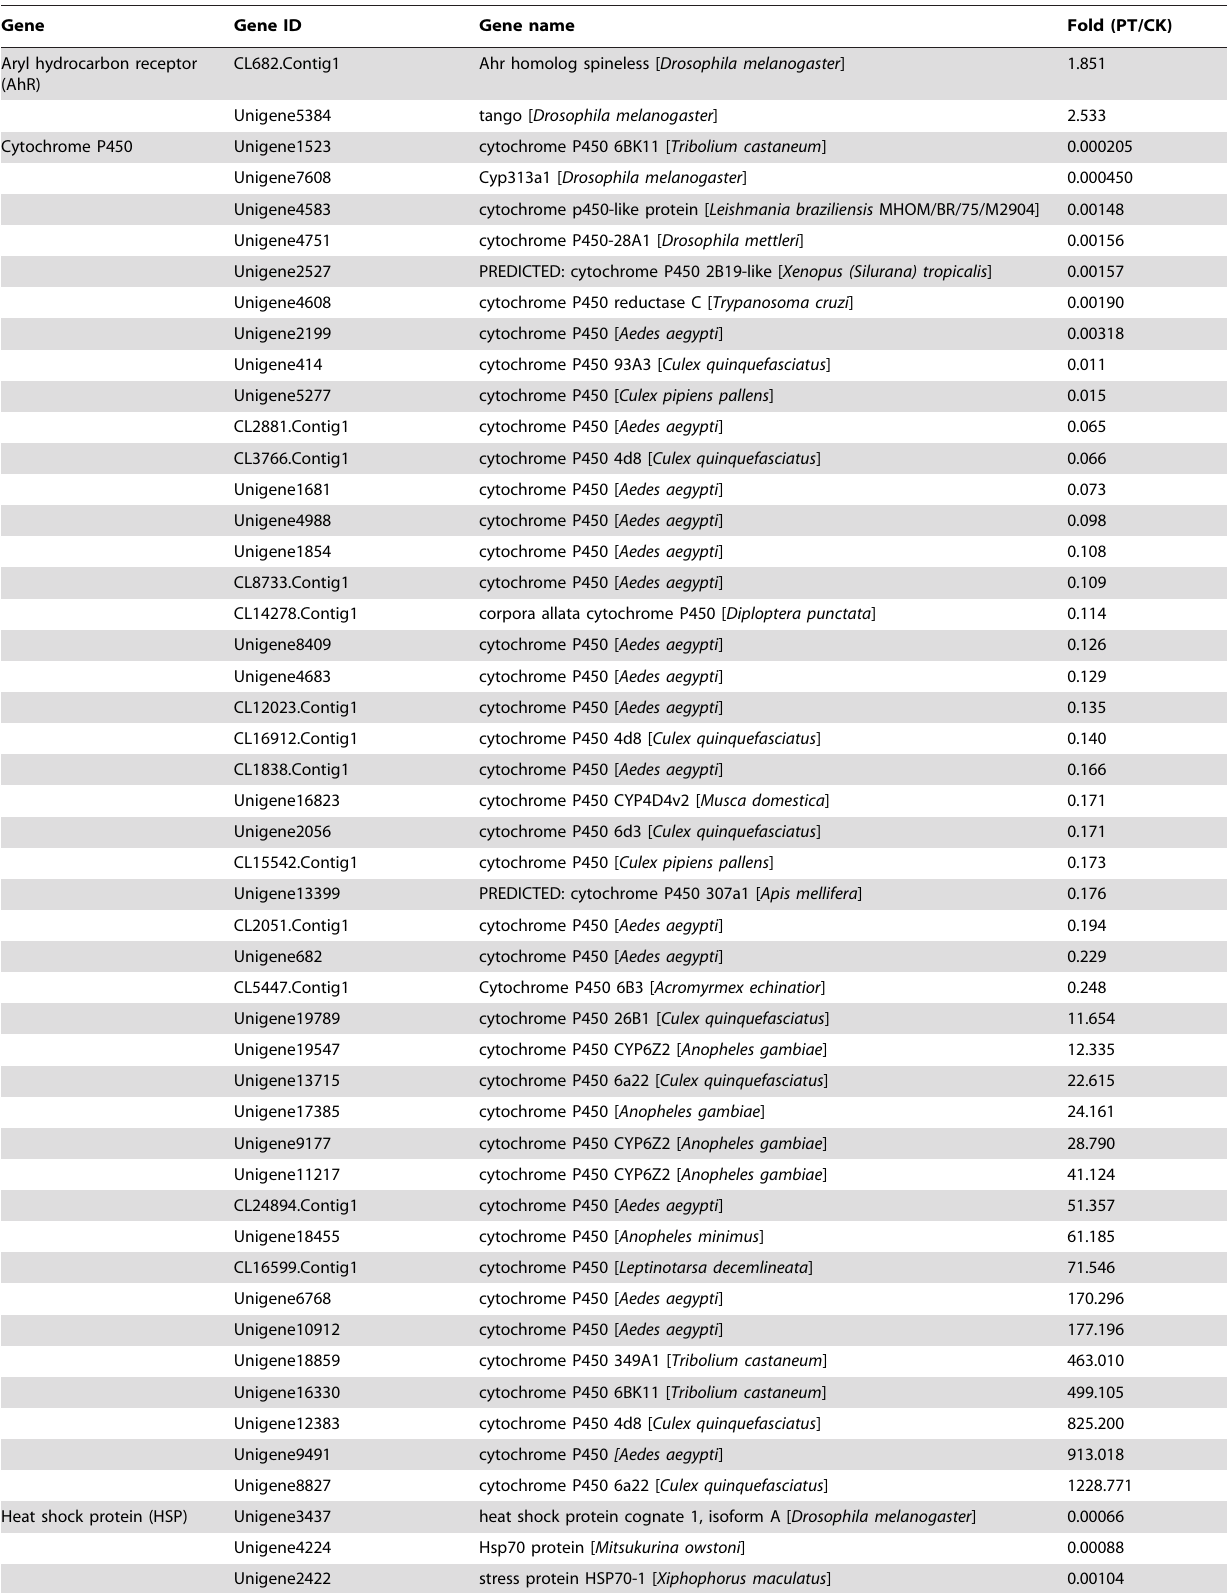
Table 5. AhR-mediated defense genes associated with phenol stress.